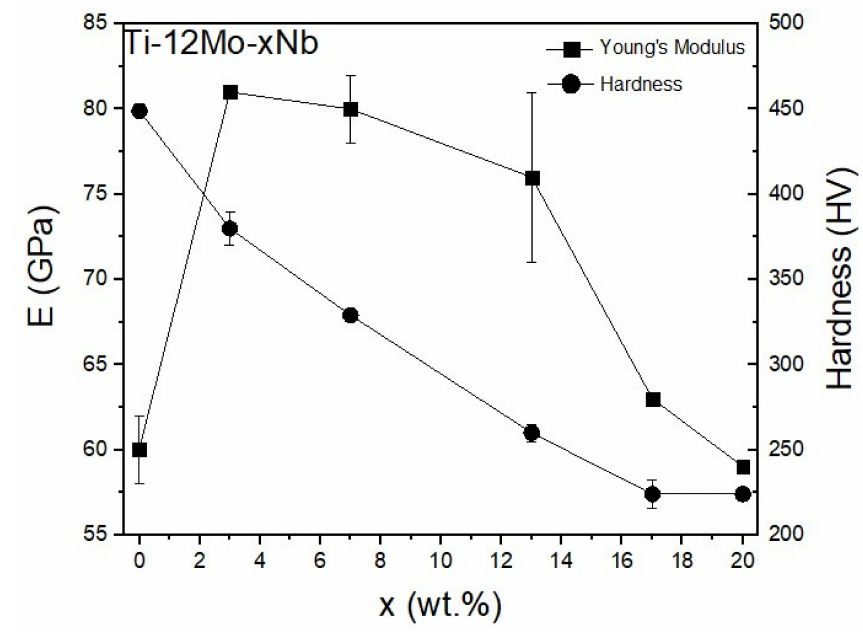
Figure 4. Microhardness and Young’s modulus values in function of addition